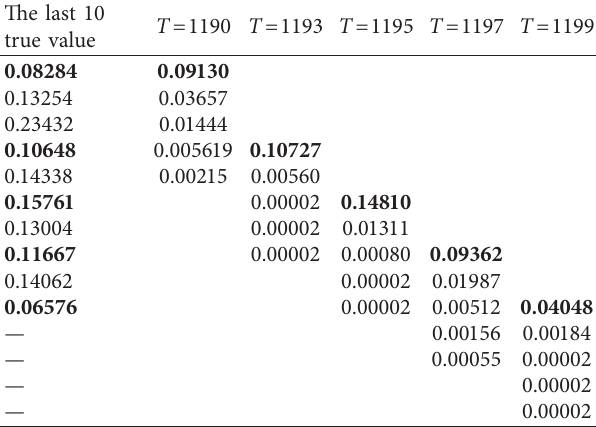
Table 6: 5 days ahead volatility prediction analysis of the fuzzy- EGARCH-ANN model.